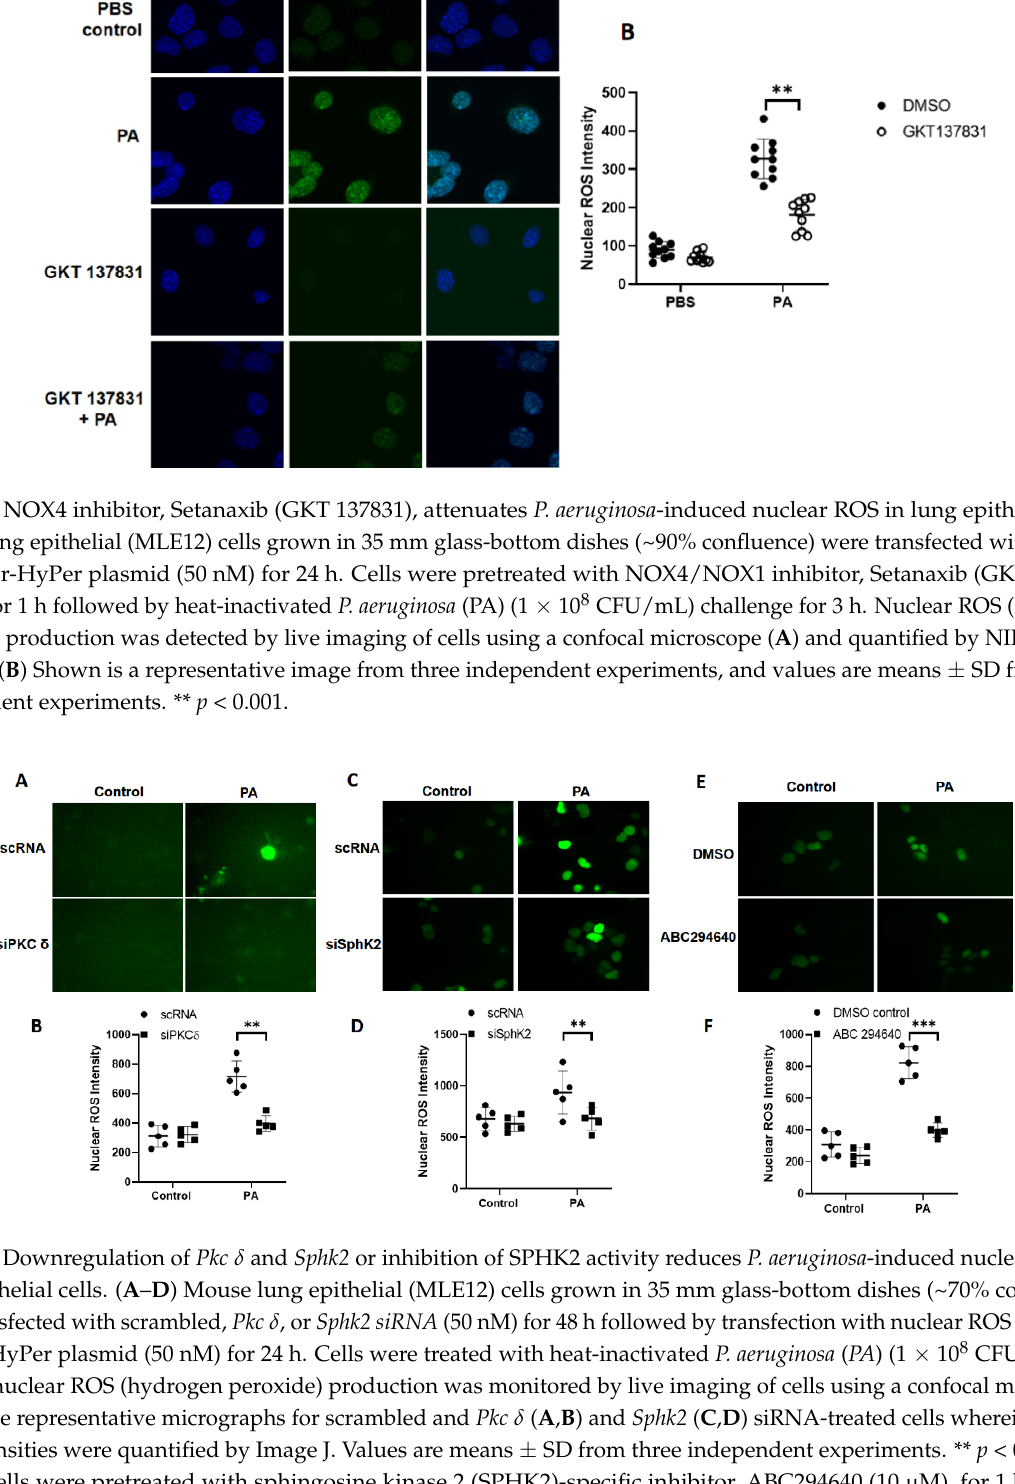
Figure 6. Downregulation of Pkc δ and Sphk2 or inhibition of SPHK2 activity reduces P. aeruginosa -induced nuclear ROS in lung epithelial cells. ( A – D ) Mouse lung epithelial (MLE12) cells grown in 35 mm glass-bottom dishes (~70% confluence) were transfected with scrambled, Pkc δ , or Sphk2 siRNA (50 nM) for 48 h followed by transfection with nuclear ROS biosensor nuclear-HyPer plasmid (50 nM) for 24 h. Cells were treated with heat-inactivated P. aeruginosa ( PA ) (1 × 10 8 CFU/mL) for 3 h, and nuclear ROS (hydrogen peroxide) production was monitored by live imaging of cells using a confocal microscope. Shown are representative micrographs for scrambled and Pkc δ ( A , B ) and Sphk2 ( C , D ) siRNA-treated cells wherein nuclear ROS intensities were quantified by Image J. Values are means ± SD from three independent experiments. ** p < 0.01. ( E , F ) MLE12 cells were pretreated with sphingosine kinase 2 (SPHK2)-specific inhibitor, ABC294640 (10 μ M), for 1 h prior to challenge with heat-inactivated PA (1 × 10 8 CFU/mL) for 3 h, and nuclear ROS (hydrogen peroxide) production was monitored by live imaging of cells using a confocal microscope. Shown is a representative micrograph. Values are means ± SD from three independent experiments. *** p < 0.001.